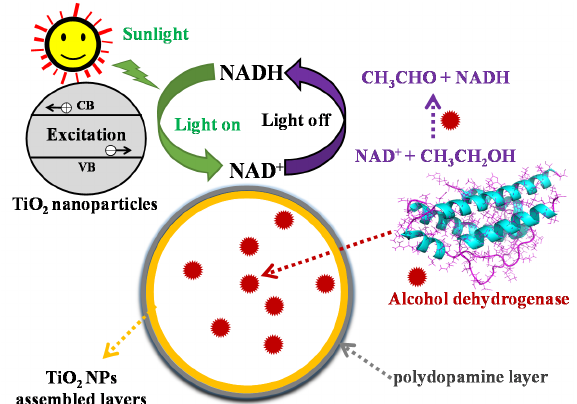
Figure 1. Schematic illustration of the cycling of nicotinamide coenzymes NAD + /NADH catalyzed by the bioinspired ADH@TiO 2 NP microreactors. The polydopamine layer was formed by means of in situ polymerization of dopamine and used as a photosensitizer for the activation of the TiO 2 NP membrane under visible light. During cycling of NAD + /NADH, enzymatic regeneration of NADH from NAD + reduction is catalyzed by alcohol dehydrogenase and subsequent photocatalytic oxidation to NAD + takes place by the PDA-modified TiO 2 NP membrane under visible light